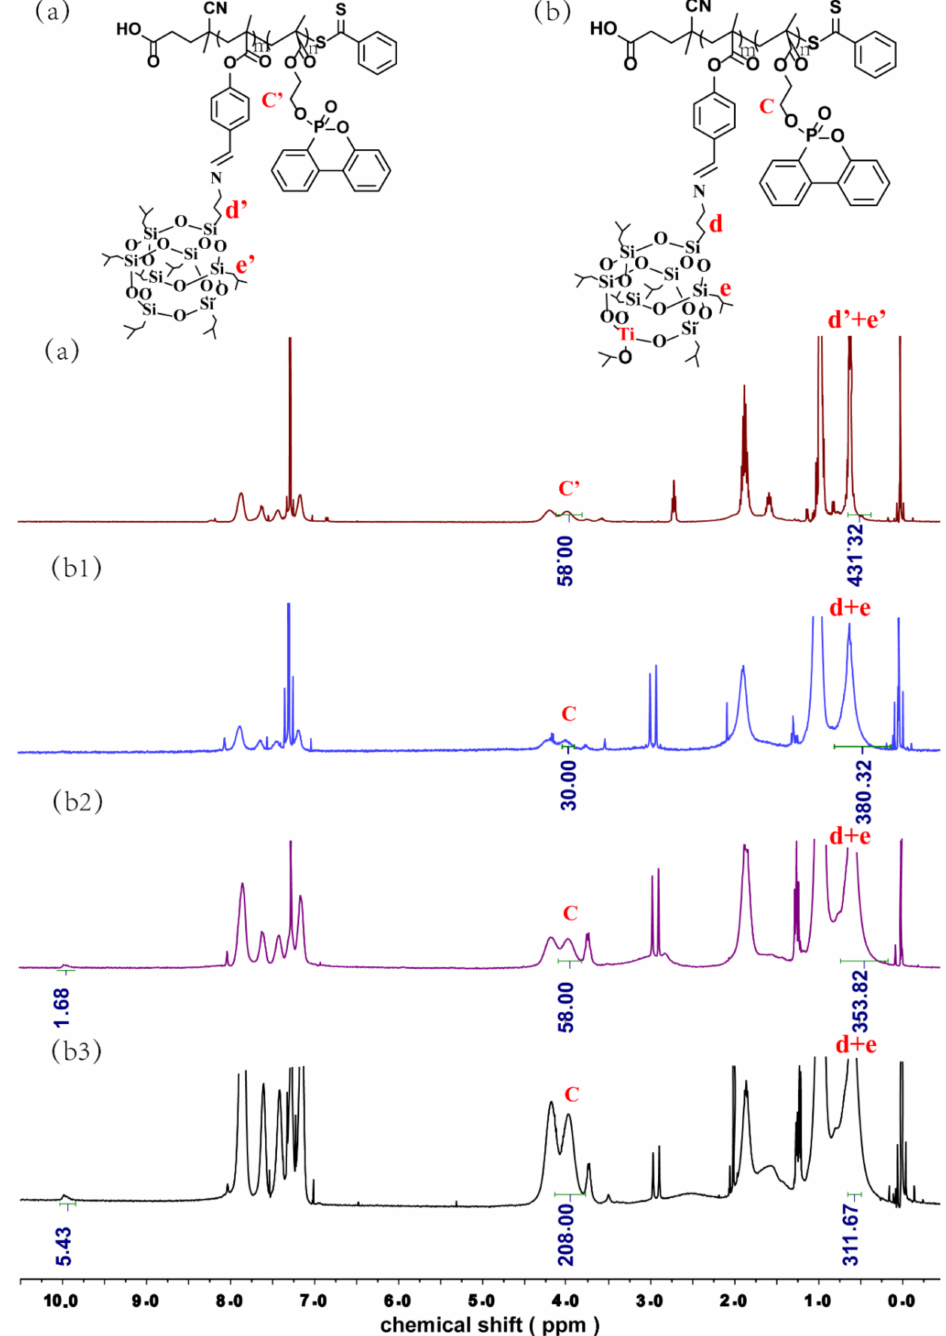
Figure 4. The 1 H NMR spectra of grafted polymer: ( a ) PolyC, ( b1 – b3 ) PolyTi1, PolyTi2, and